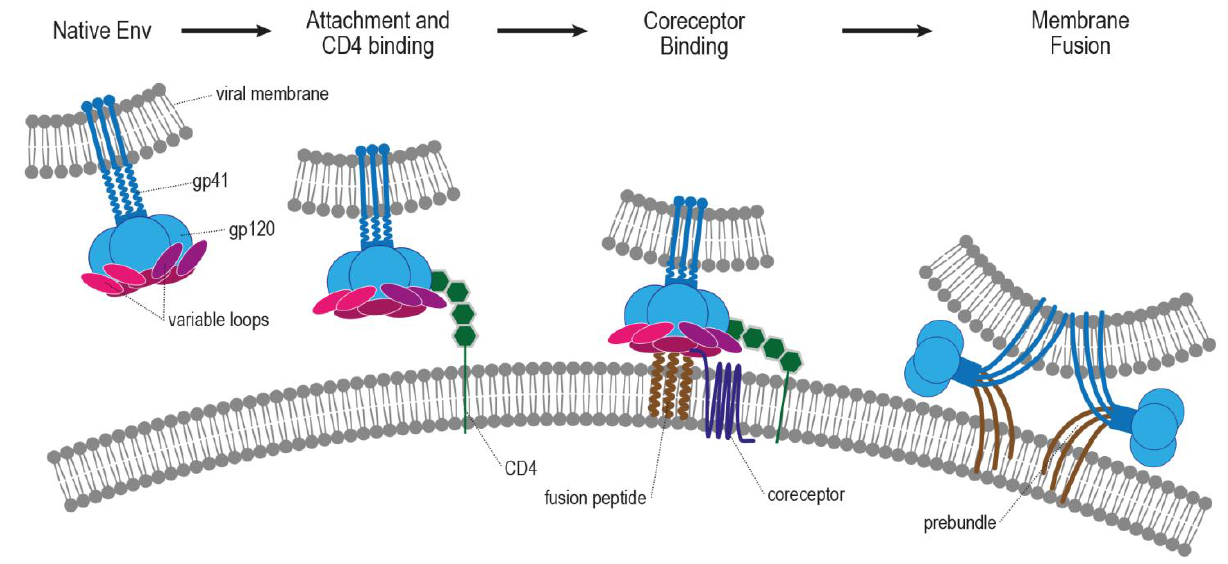
Figure 6: Working model of HIV-1 entry. HIV entry is initiated by attachment of gp120 to CD4, which induces a conformational change in gp120. Following engagement of coreceptor, gp120 undergoes further conformational changes that allow for the insertion of the gp41 fusion peptide into the host membrane. The formation of the six-helix bundle brings the host and viral membranes into close proximity and creates a fusion pore, allowing entry of the HIV capsid into the host cell. Adapted from